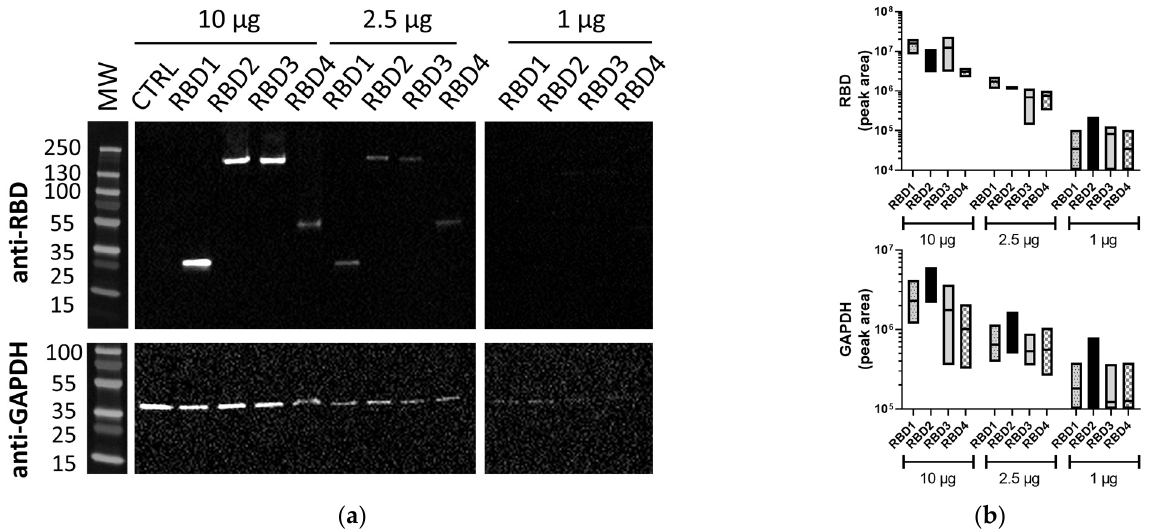
Figure 2. Lysates containing RBD proteins run using iBind™ Flex. ( a ) Image of membranes im- munoblotted with anti-SARS-CoV-2 RBD (1:2500) or anti-GAPDH (1:1000) Abs using iBind™ Flex. ( b ) Floating box plots showing the minimum, maximum, and mean of the band volumes from RBD and GAPDH bands for RBD1–4 samples from three independent experiments that were obtained using Image Lab analysis. Lysates (10, 2.5, and 1 µg/lane) were from 293T cells transfected with plasmids expressing different-sized transgenes containing the RBD (RBD1–4) or control transgene (CTRL). MW: PageRuler™ Plus Prestained Protein Ladder (Thermo Scienti fi c). The band volumes of the RBD1–4 bands were normalized to those of GAPDH, from